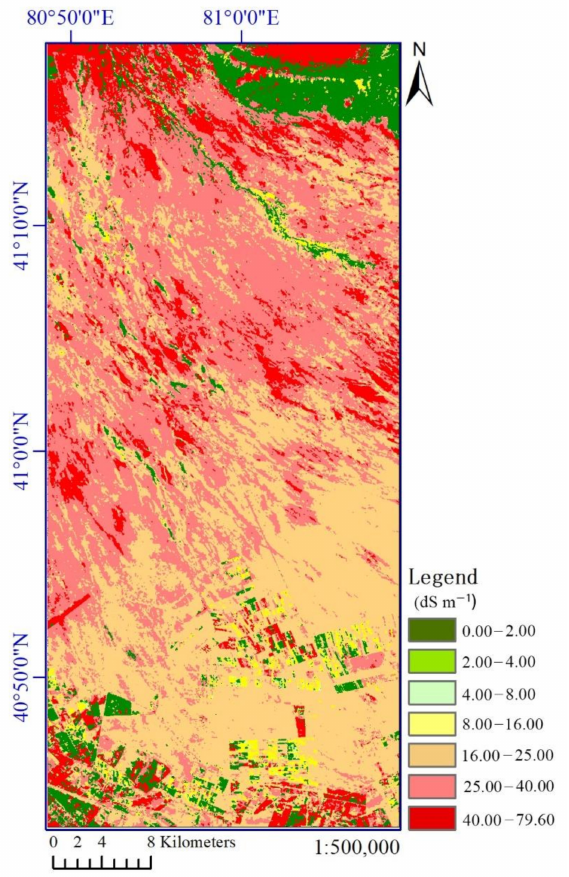
Figure 6. Soil EC distribution map derived from the SVM models based on the Sentinel-2B MSI